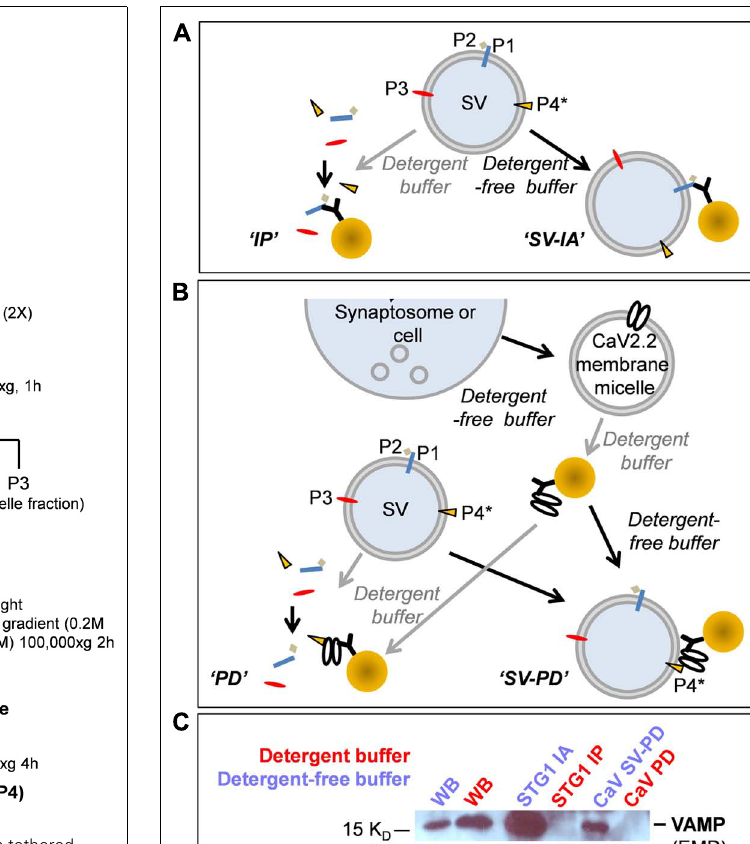
FIGURE 1 | (A) Hypothetical model of SV tethering.The SV is tethered directly to the calcium channel. (B) Synaptosome membrane and synaptic vesicle purification protocols (see Materials and Methods).